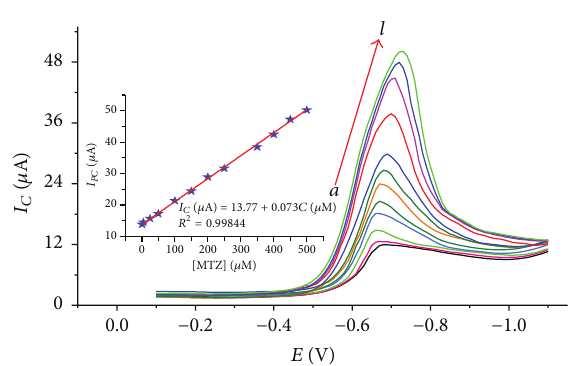
Figure 6: Square wave voltammograms of CPE (corrected for background) in pH 7.0 BRB solution containing MTZ of various concentrations ( a – l : 1, 5, 25, 50, 100, 150, 200, 250, 350, 400, 450, and 500 𝜇 M, resp.). Inset: calibration curve of peak current versus concentration of MTZ. Experimental conditions: square